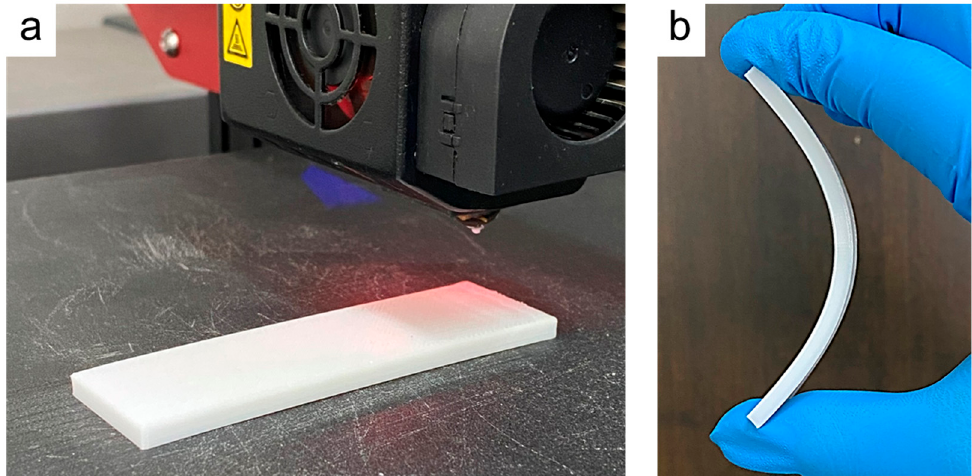
Figure 3. Optical images of ( a ) the 3D-printed FOHP and ( b ) the FOHP with a bending angle of 90°.